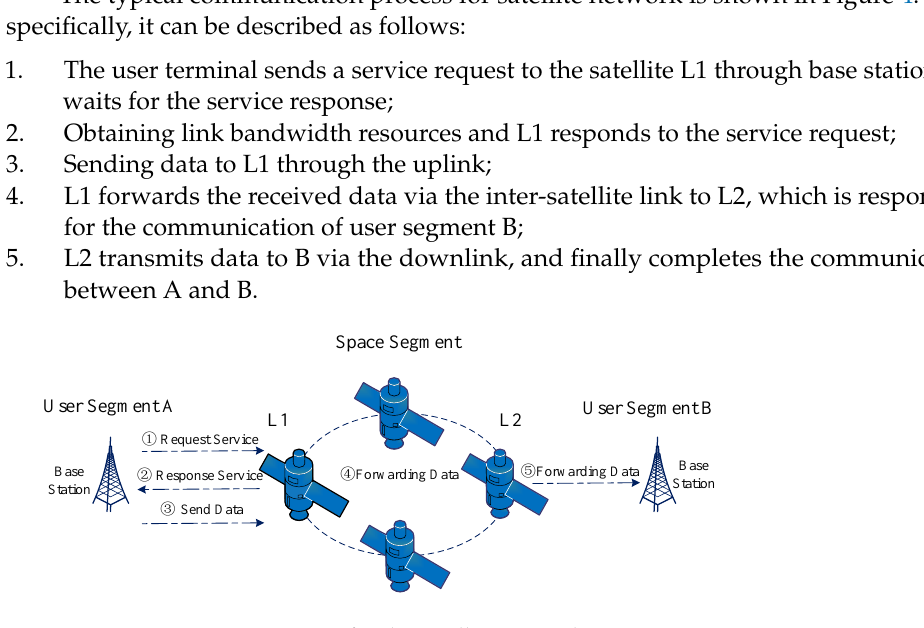
Figure 4. Communication process for the satellite